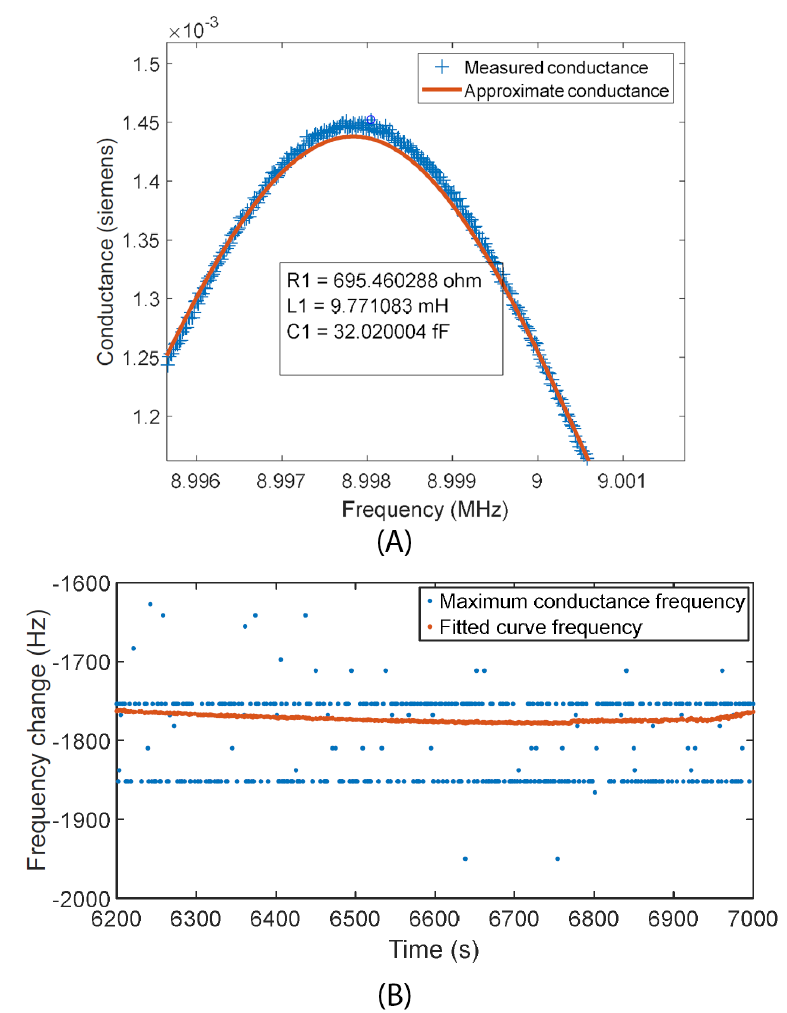
Figure 25. Improvement of signal-to-noise ratio for the VNWA measurement. ( A ) Curve fitting using the equivalent circuit. ( B ) Comparison of data obtained by curve fitting and raw maximum conductance measurement. © 2021 IEEE. Reprinted, with permission, from IEEE Sensors